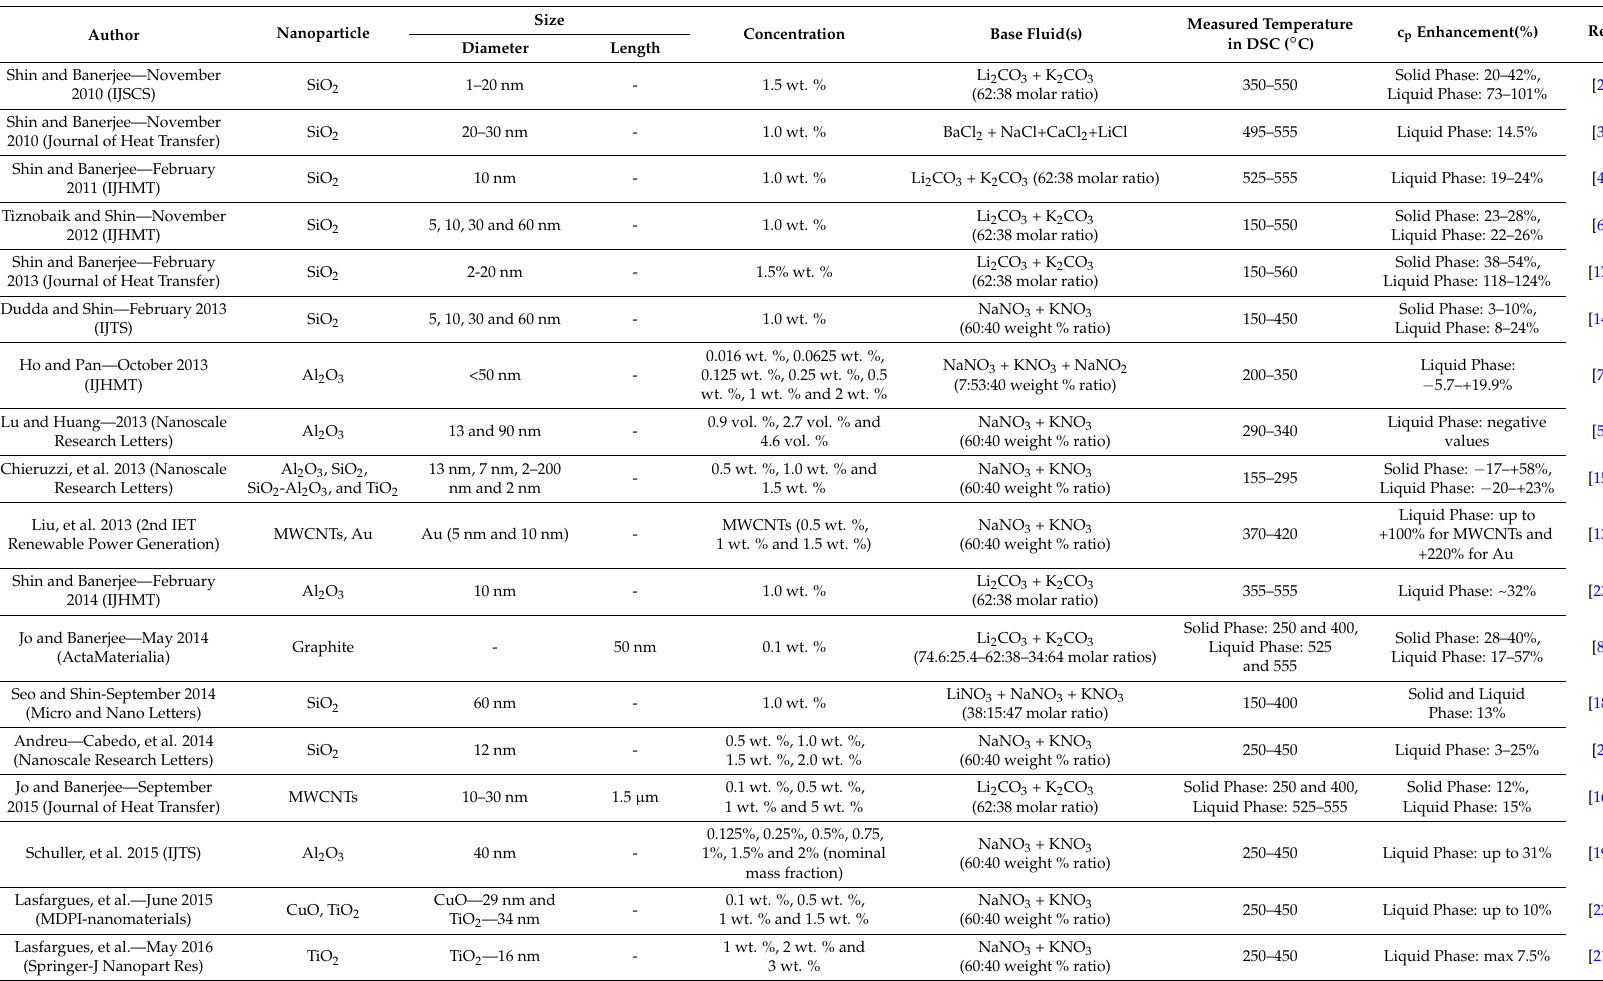
Table 1. First 16 Rows: Research papers using the dissolution, sonication and drying method to disperse the nanoparticles within the salt [2–8,13–23]. 17th Row: Dispersion of nanoparticles through the powder mixing method [22]. 18th Row: Production of nanoparticles within molten salt using a precursor